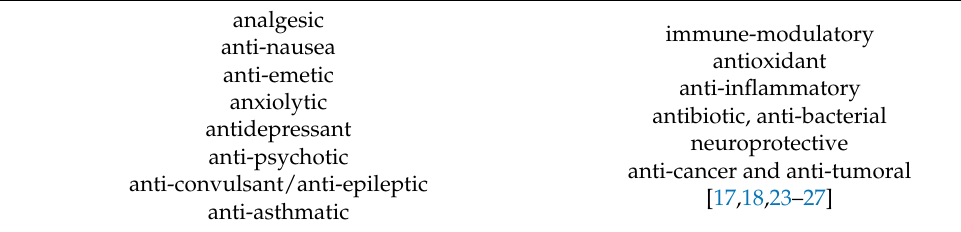
Table 1. Therapeutic Actions of CBD (adapted from